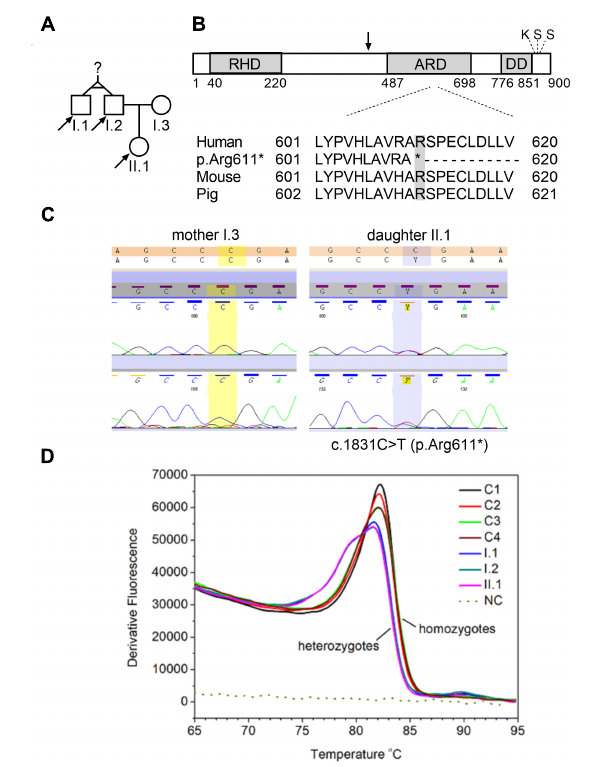
FIGURE 1 | NFKB2 c.1831C > T nonsense mutation. (A) Pedigrees of tested family, arrows indicate family members diagnosed with c.1831C > T (p.Arg611 ∗ ) nonsense mutation that were seeking a genetic testing. (B) Schematic representation of p100 domains showing rel homology domain (RHD), ankyrin repeat domain (ARD), and death domain (DD). Black arrow indicate processing position of p100, the location of the conserved lysine (K855) and two conserved serine s (S866 and S870) is also depicted on the scheme (Wietek and O’Neill, 2007, modified). Multiple sequence alignment of amino acid sequences in the fragment of ARD domain. (C) Sanger sequencing of two individuals over the c.1831 position. Left panel shows wild-type c.1831 position (mother, I.3) and right panel shows the c.1831C > T variant (daughter, II.1). (D) High resolution melt analysis of DNA product amplified in the real-time PCR reaction. 49 bp amplicons generated over mutated nucleotide were analyzed by HRM. Only one product is detected in control subjects, whereas all three samples collected from NFKB2 haplodeficient subjects generated a bimodal melt curve, together with a shift toward lower melting